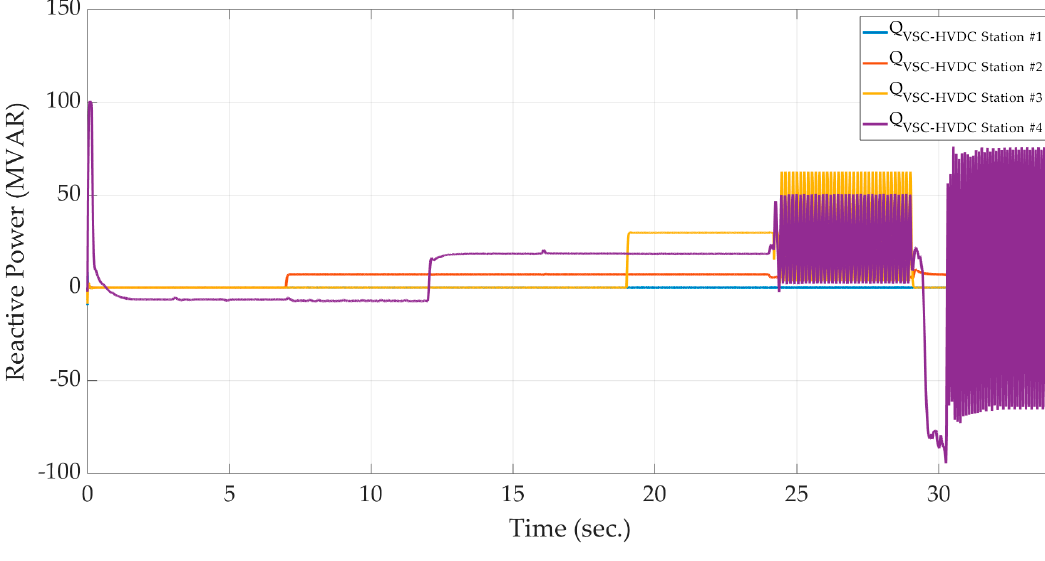
Electronics 2020 , 9 , 87 Figure 11. The active power profile of di ff erent VSC-HVDC stations in the first scenario. Figure 11. The active power profile of different VSC-HVDC stations in the first scenario.